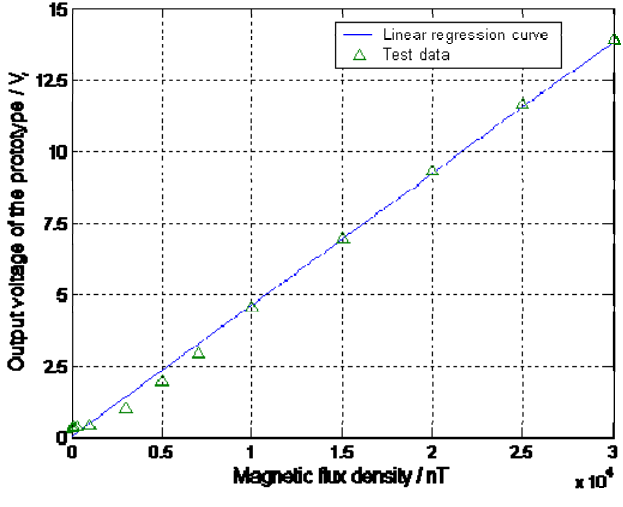
Figure 17. The Output performance of the magnetometer prototype